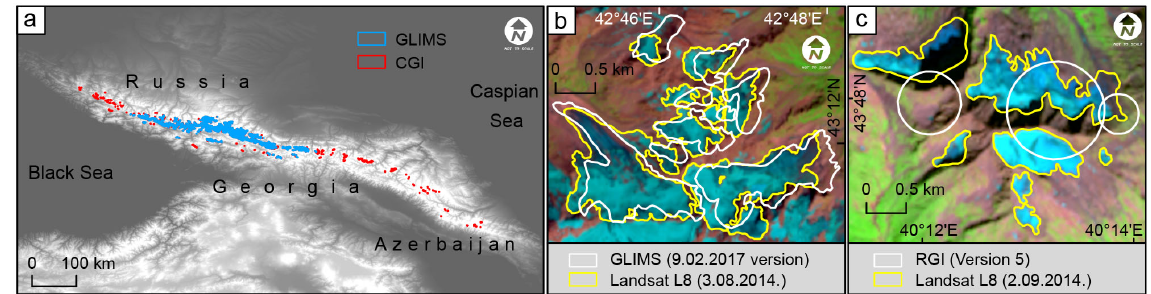
Figure 10. (a) Comparison of the GLIMS with the new Caucasus Glacier Inventory (CGI). (b) The GLIMS outlines an example of inconsis- tent registration. (c) Glacier outlines from 2014, showing the RGI nominal glaciers (circles).